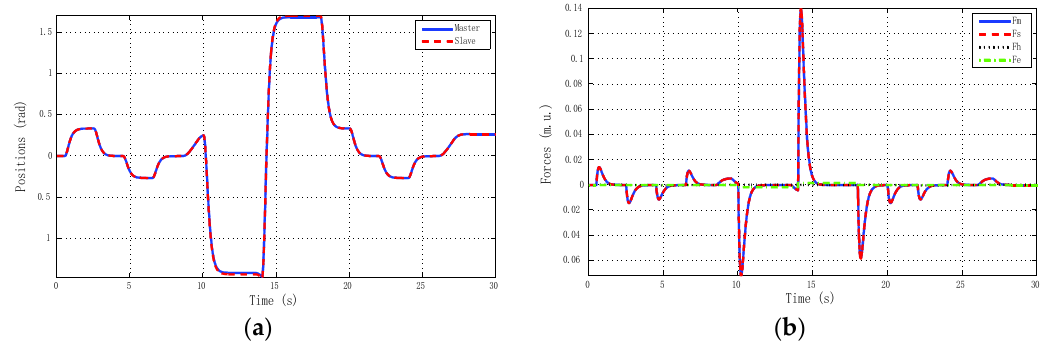
Figure 11. Simulated ramp-step reference force: γ-4C control scheme with h max = 0, d = 0. ( a ) Positions; ( b ) Forces.